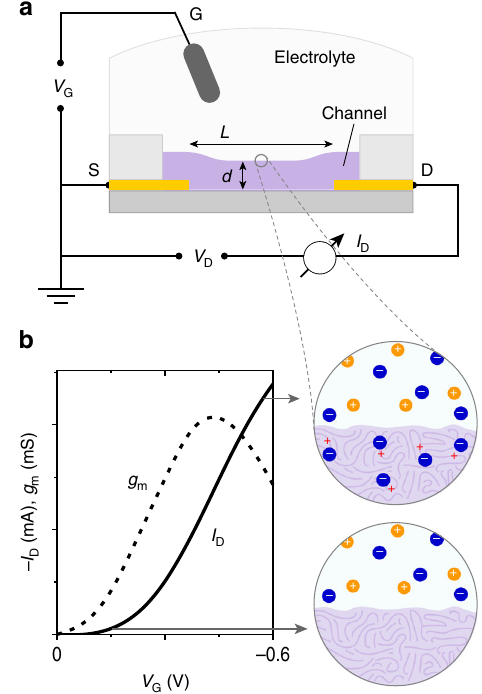
Fig. 1 OECT description and operation. a OECT cross section, wiring, and dimensions: channel length ( L ), and thickness ( d ). The source, drain, and gate (S, D, G, respectively), and relevant voltages (gate, drain voltage: V G , V D ) and currents (drain current, I D ) terms are also labeled. b Representative transfer ( I D − V G ) curve for a p-type accumulation mode device ( V D < 0 V), and the corresponding transconductance curve ( g m ). The schematics on the right indicate the doping state of the fi lm, where the “ ON ” state allows for anion drift/penetration and subsequent stabilization of holes on the semiconducting backbone. In the schematics, cations are orange, anions are blue, and holes are